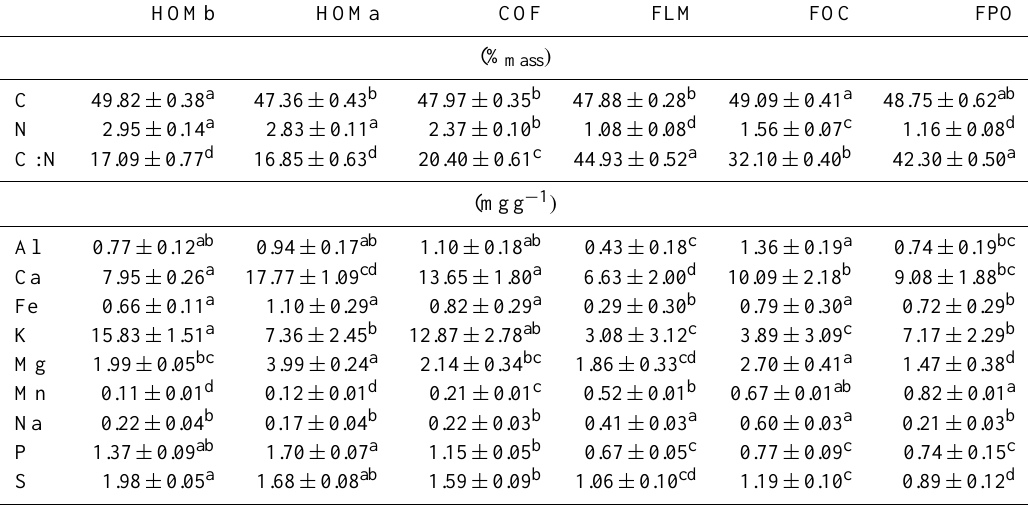
Table A1. Nutrient content in leaf litter ( ± SE) from six ecosystems at Mt. Kilimanjaro, Tanzania. Superscript letters indicate significant differences between the sites (derived from Kruskal-Wallis Test; p level ≤